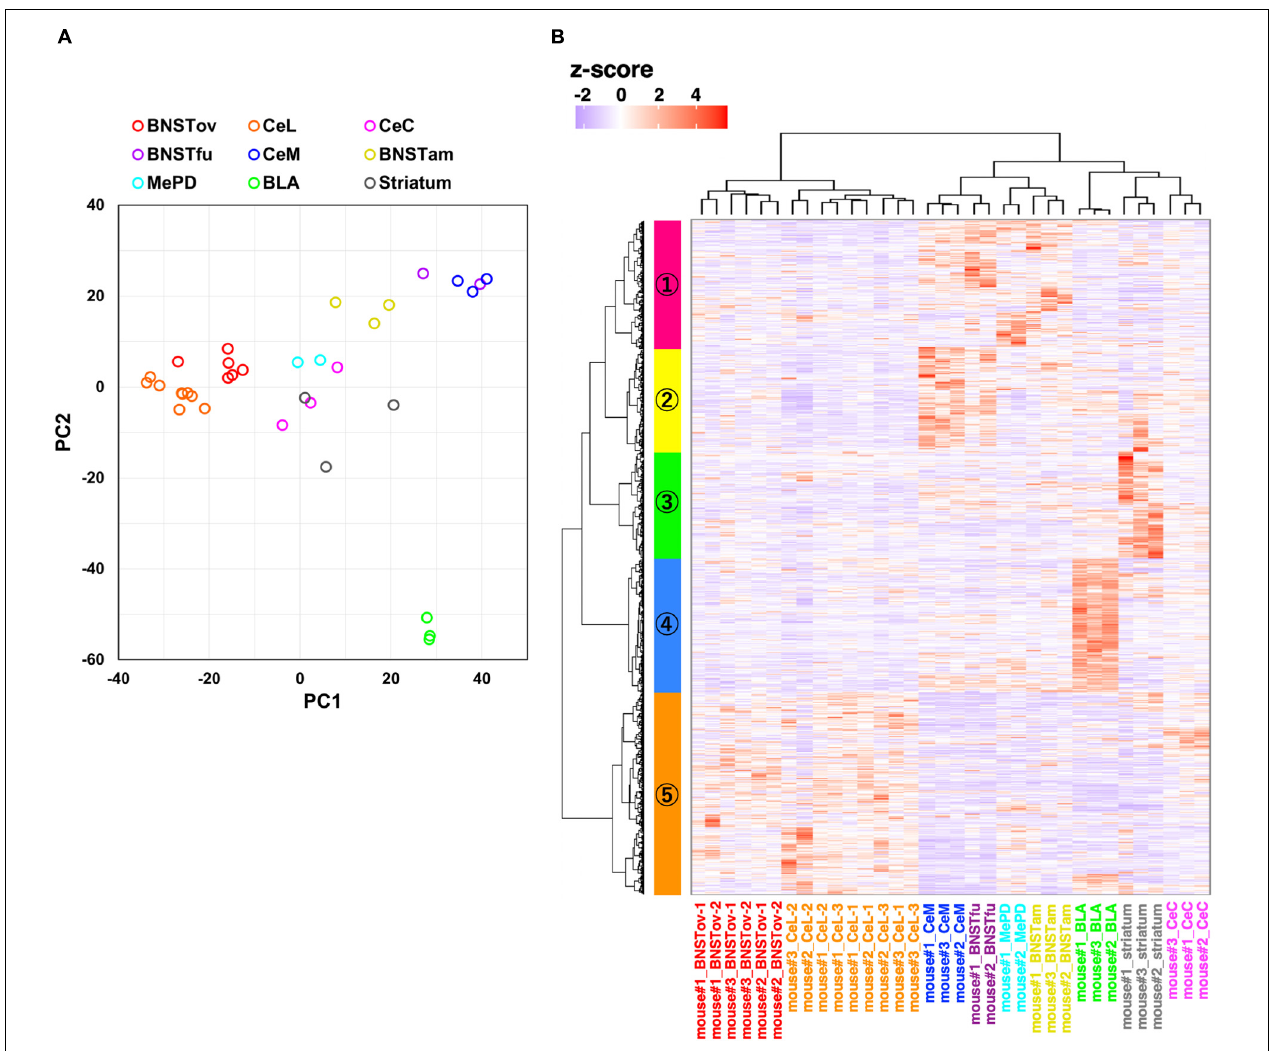
FIGURE 4 | Gene expression profiling from amygdala-related subnuclei. (A) PCA using normalized RNA-seq data of 2,800 inter-subnuclei differentially expressed genes (DEGs subnuc ). (B) Hierarchical clustering of relative gene expression of 2,800 DEGs subnuc . The horizontal and vertical axes represent each sample and DEGs, respectively. The color scale reflects z -score of CPM